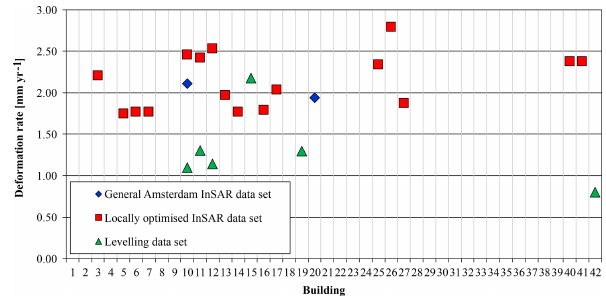
Figure 5. Buildings in the case study with deformation rates ex- ceeding 2mmyr − 1 with probability larger than 5%, identified by using the levelling data set and the two InSAR data sets. Table 1. Summary of coverage in the three case studies. levelling general local InSAR InSAR number of